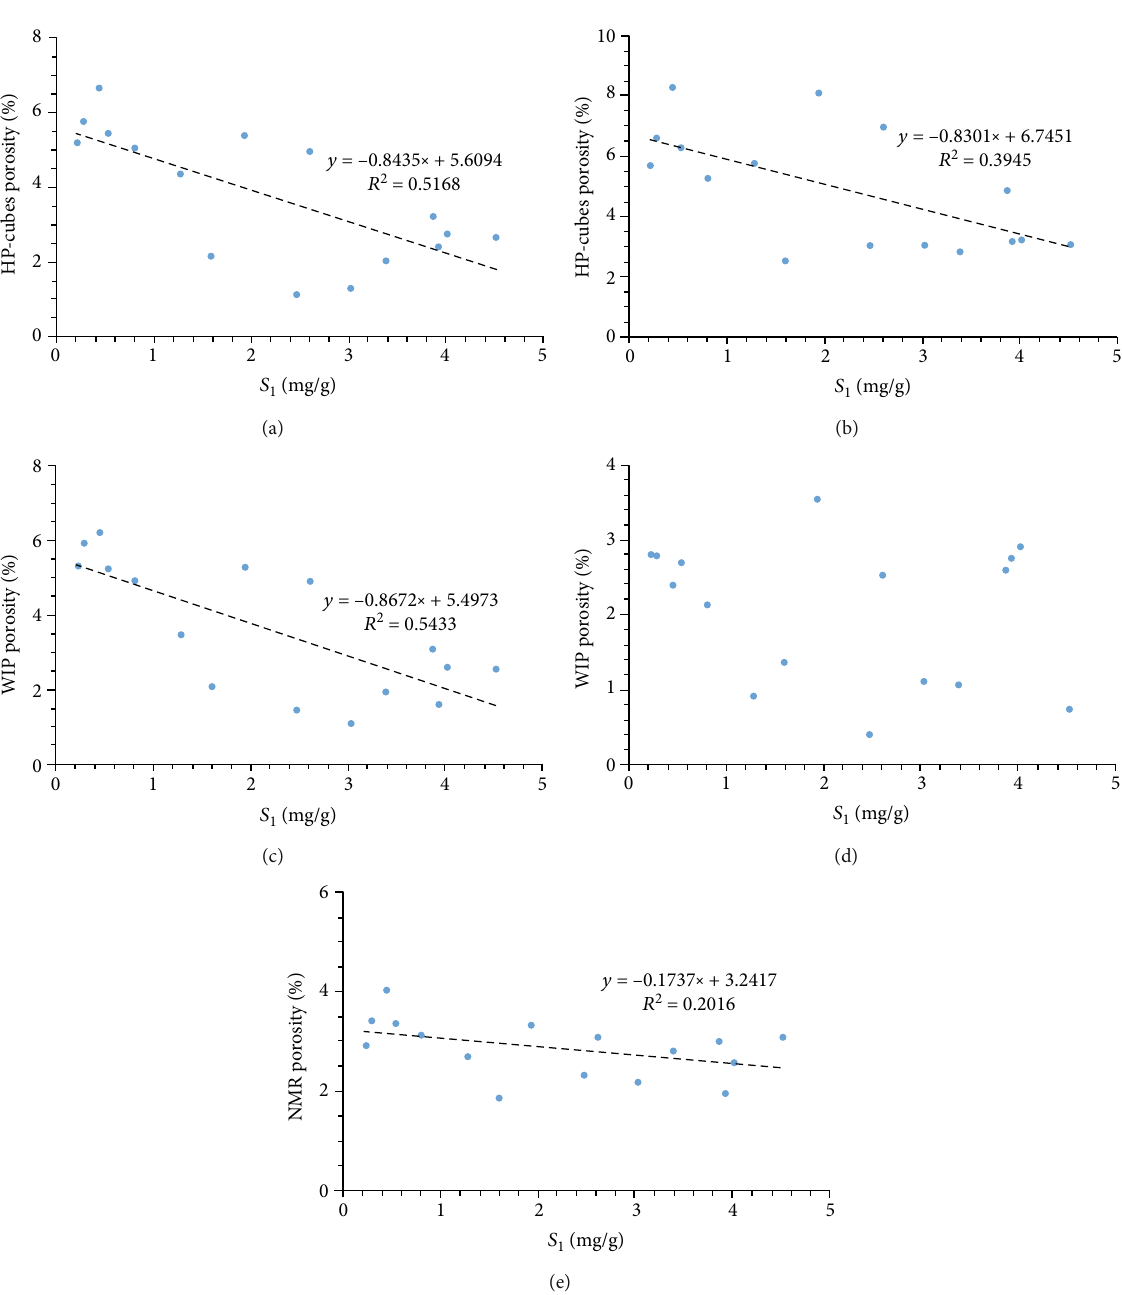
and porosities from di ff erent 1